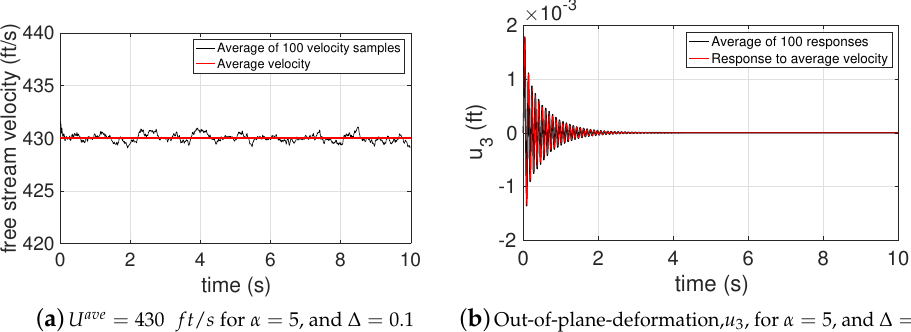
Figure 21. Illustration of law of large numbers with 100 samples for an stable average velocity.